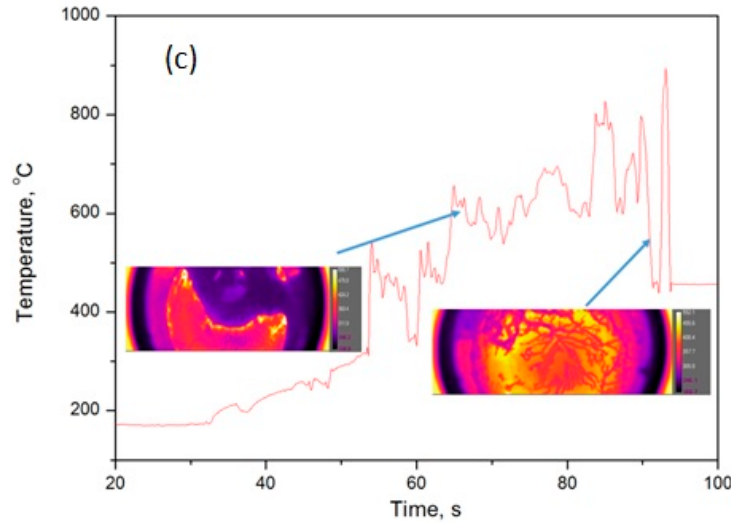
Figure 4. The influence of precursor concentration in water on combustion temperature during SCS: ( a ) 100 mL, ( b ) 75 mL, and ( c ) 50 mL (preheating temperature 300 ◦ C).